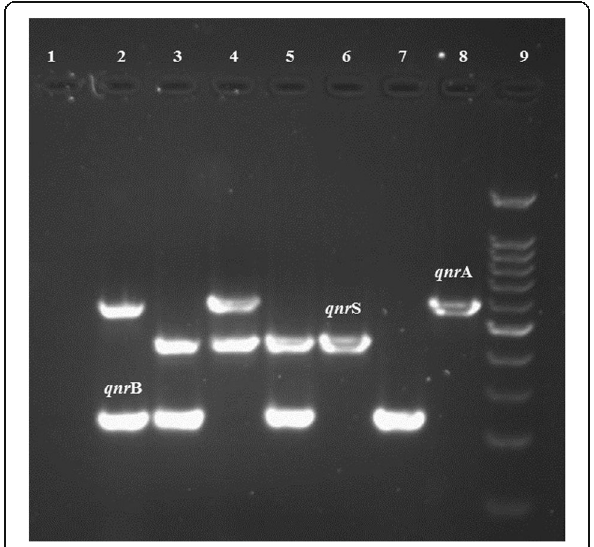
Fig. 2 Agarose gel electrophoresis of qnr A (580 bp), qnr B (264 bp), and qnr S (428 bp) genes of multiplex PCR amplification products. Left to right lane: lane 1 negative control; lanes 6, 7, and 8 positive control for qnr S, qnr B, and qnr A, respectively; lane 2 qnr A and B; lane 3 qnr S and B; lane 4 qnr A and S; lane 9 100 bp DNA